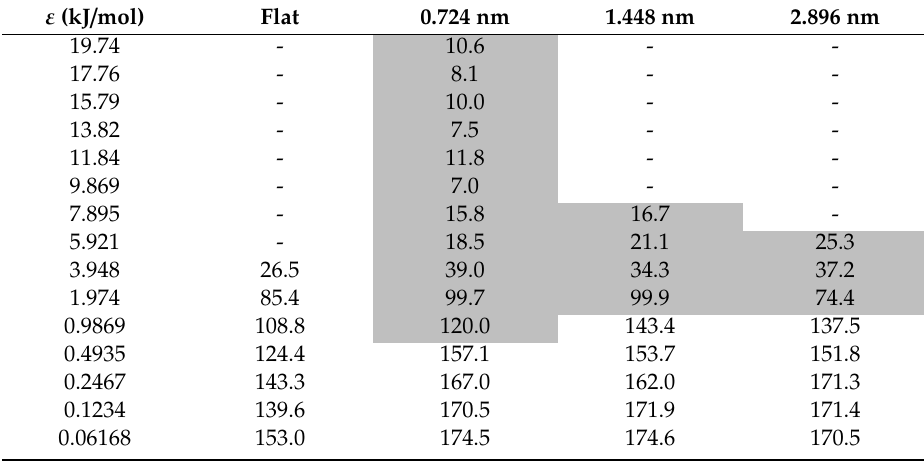
Figure 5. Relation between the water–wall interaction and the contact angle. The surface with asperity resulted in the increase of the contact angle. Table 2. Contact angle and wetting state of 5-nm droplets on each surface. The numbers on the gray background correspond to the Wenzel state, whereas the numbers without background correspond to the Cassie state.